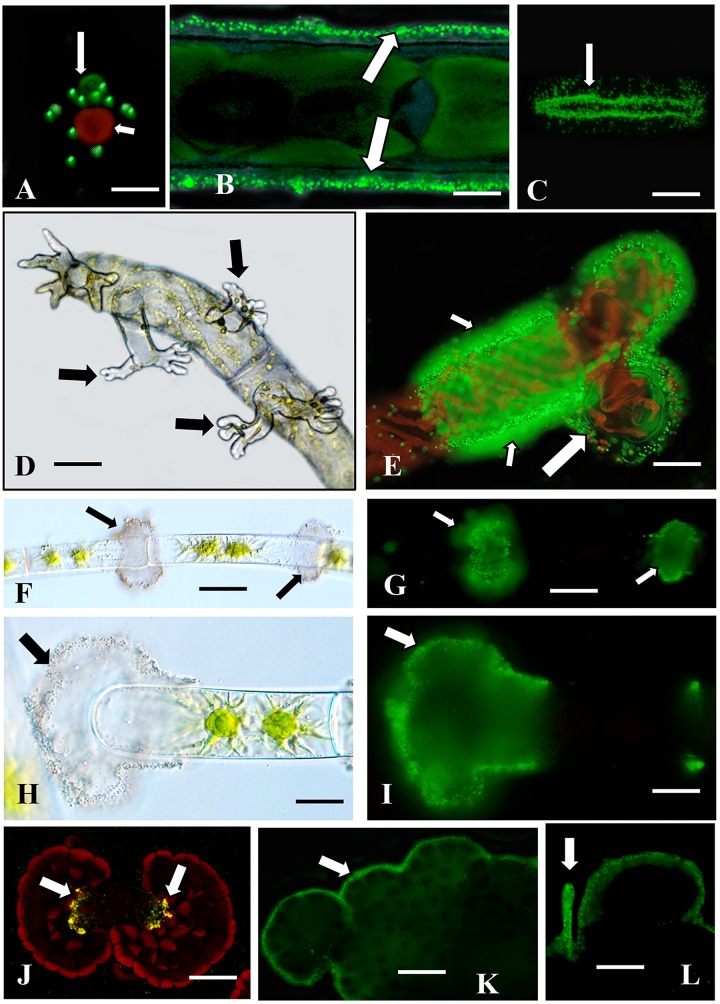
Adhesion zones identified with fluorescent beads.
(A)
Chlorokybus (small arrow) adheres to glass or plastic substrates. Fluorescent beads label the zone adjacent to the cell attachment site (large arrow). Bar 5.2 μm. (B) Bead labeling of the cell wall surface of Penium (arrows) after EPS was washed from the cell surface. Bar 45.3 μm. (C) Bead labeling of the adhesive “footprint” (arrow) that remains on the substrate after Penium is washed from substrate surface. Bar 45.3 μm. (D) Rhizoids (arrows) emerge from live cells immediately adjacent to the wound zone in a wounded Spirogyra filament. Bar 21.1 μm. (E) Bead labeling of a sheath that is external to the cell wall of growing rhizoids (large arrow). Note that the surface of the rhizoid producing cell also labels (small arrows). (F,G) Labeled “clouds” of beads are found at the cross-wall areas of planktonic Zygnema filaments (arrows). (H,I) Bead labeling at the sheath surrounding the cell at a fragmentations site (arrow). (J) Bead labeling of the center thallus zones of Coleochaete (arrows). (K) The beads also label the thallus margins (K, arrow) and the hairs emerging from the dorsal side of the thallus (L, arrow). Bars (F–L) 5.2 μm.